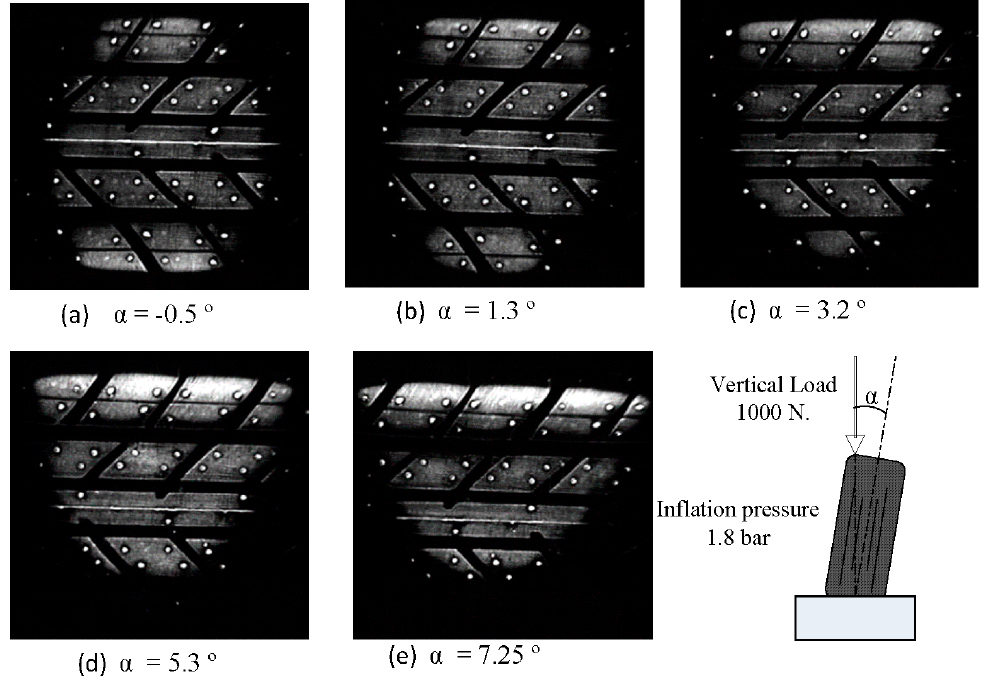
Figure 14. Contact patch at various camber angles.